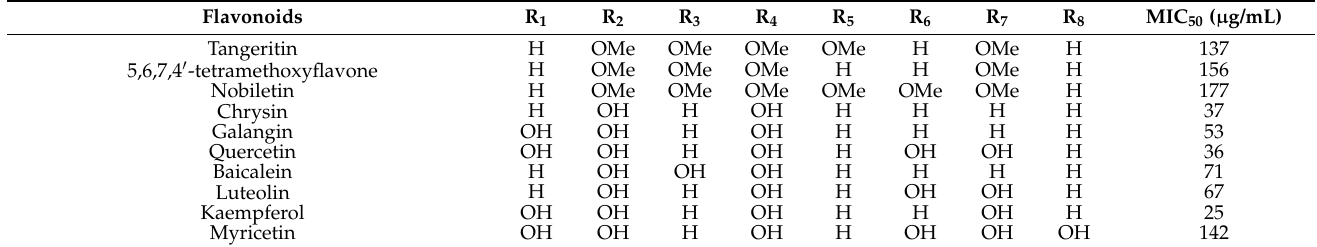
Figure 5. The SAR of flavonoids as antibacterial agents by inhibiting the DNA gyrase activity [62]. Table 3. Flavonoids compounds displayed good E. coli DNA gyrase inhibition.